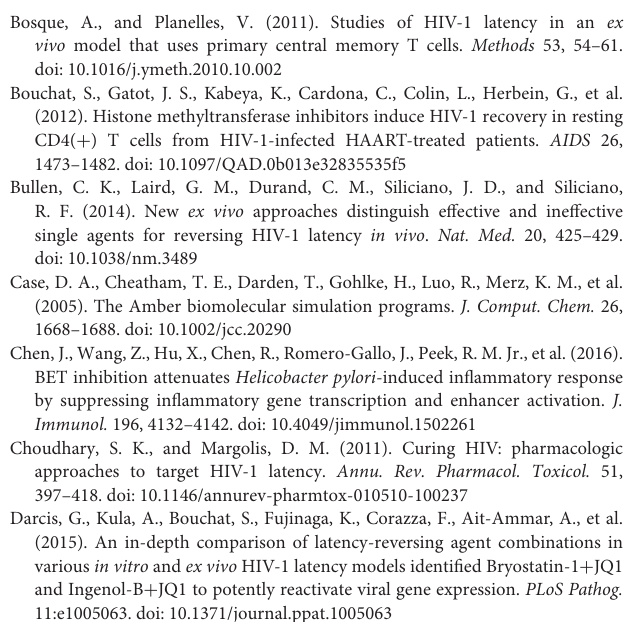
Figure S1 | (A) The HIV-1 latency-reversing potential of a structural mimic of UMB-136, UMB-283. J-Lat A2 cells were treated with UMB-136, UMB-283, or DMSO at indicated concentrations for 24 h and followed by flow cytometry to sort GFP positive cells. (B) Cytotoxicity of UMB-136 and JQ1. Jurkat cells were treated with drugs at a series of concentrations as indicated for 24 h and subjected to measurement of total ATP levels using Cell Titer Glo (Promega). Figure S2 | (A) The effect of UMB-136 on the cytokine release of primary CD4 + T cells. Peripheral CD4 + T cells were treated with JQ1, UMB-136, or DMSO. Cells were then treated with anti-CD3 and CD28 antibodies. The indicated cytokines were measured using the Multi-Analyte ELISArray (QIAGEN) following the manufacturer’s instruction. (B) Live/dead cell assay of the aviremic samples treated with LRAs. CD8-depleted PBMCs from four aviremic donors were processed as shown in Figure 4B . The effect of LRA treatment on cell death was determined using LIVE/DEADTM Fixable Green Dead Cell Stain Kit (Invitrogen) according to the manufacturer’s